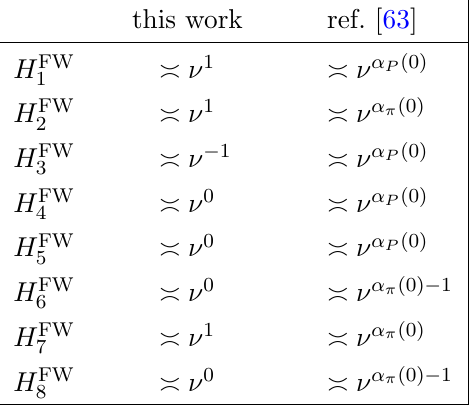
Table 6. Comparison of the assumptions about the asymptotic behavior of the helicity amplitudes. In [63], (cid:11) P (0) 1 : 08 and (cid:11) (cid:25) (0) 0 : 014 was (cid:25) (cid:25) (cid:0)